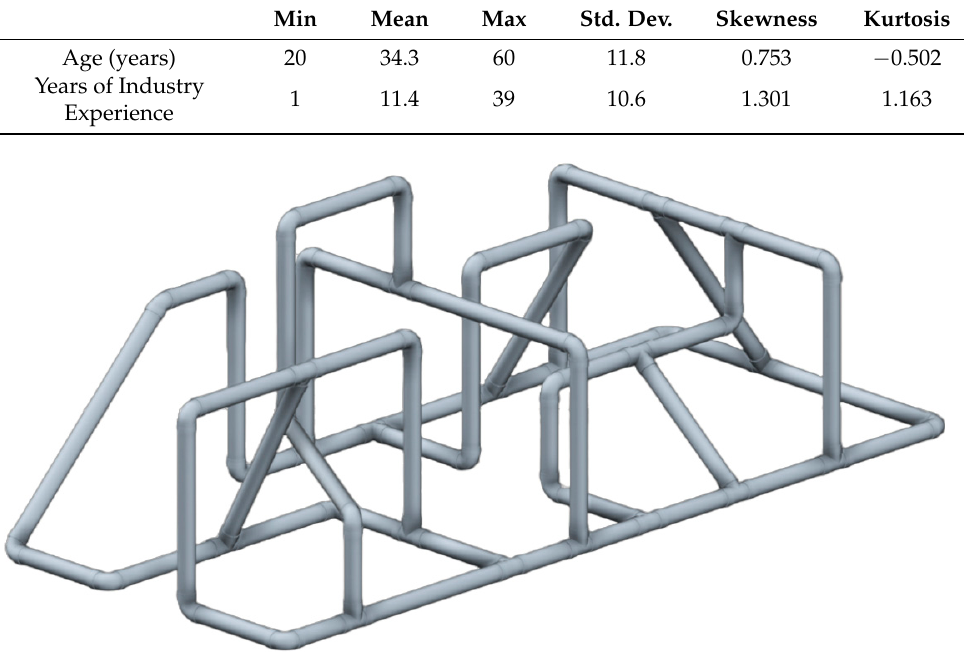
Table 2. Pipefitter experience descriptive statistics.